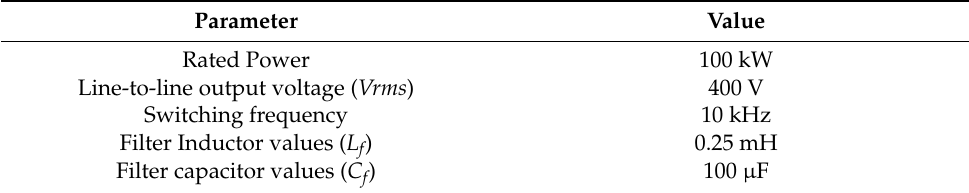
Figure 9. Schematic diagram of three-phase VSI and its controller. Table 4. Design parameters of the